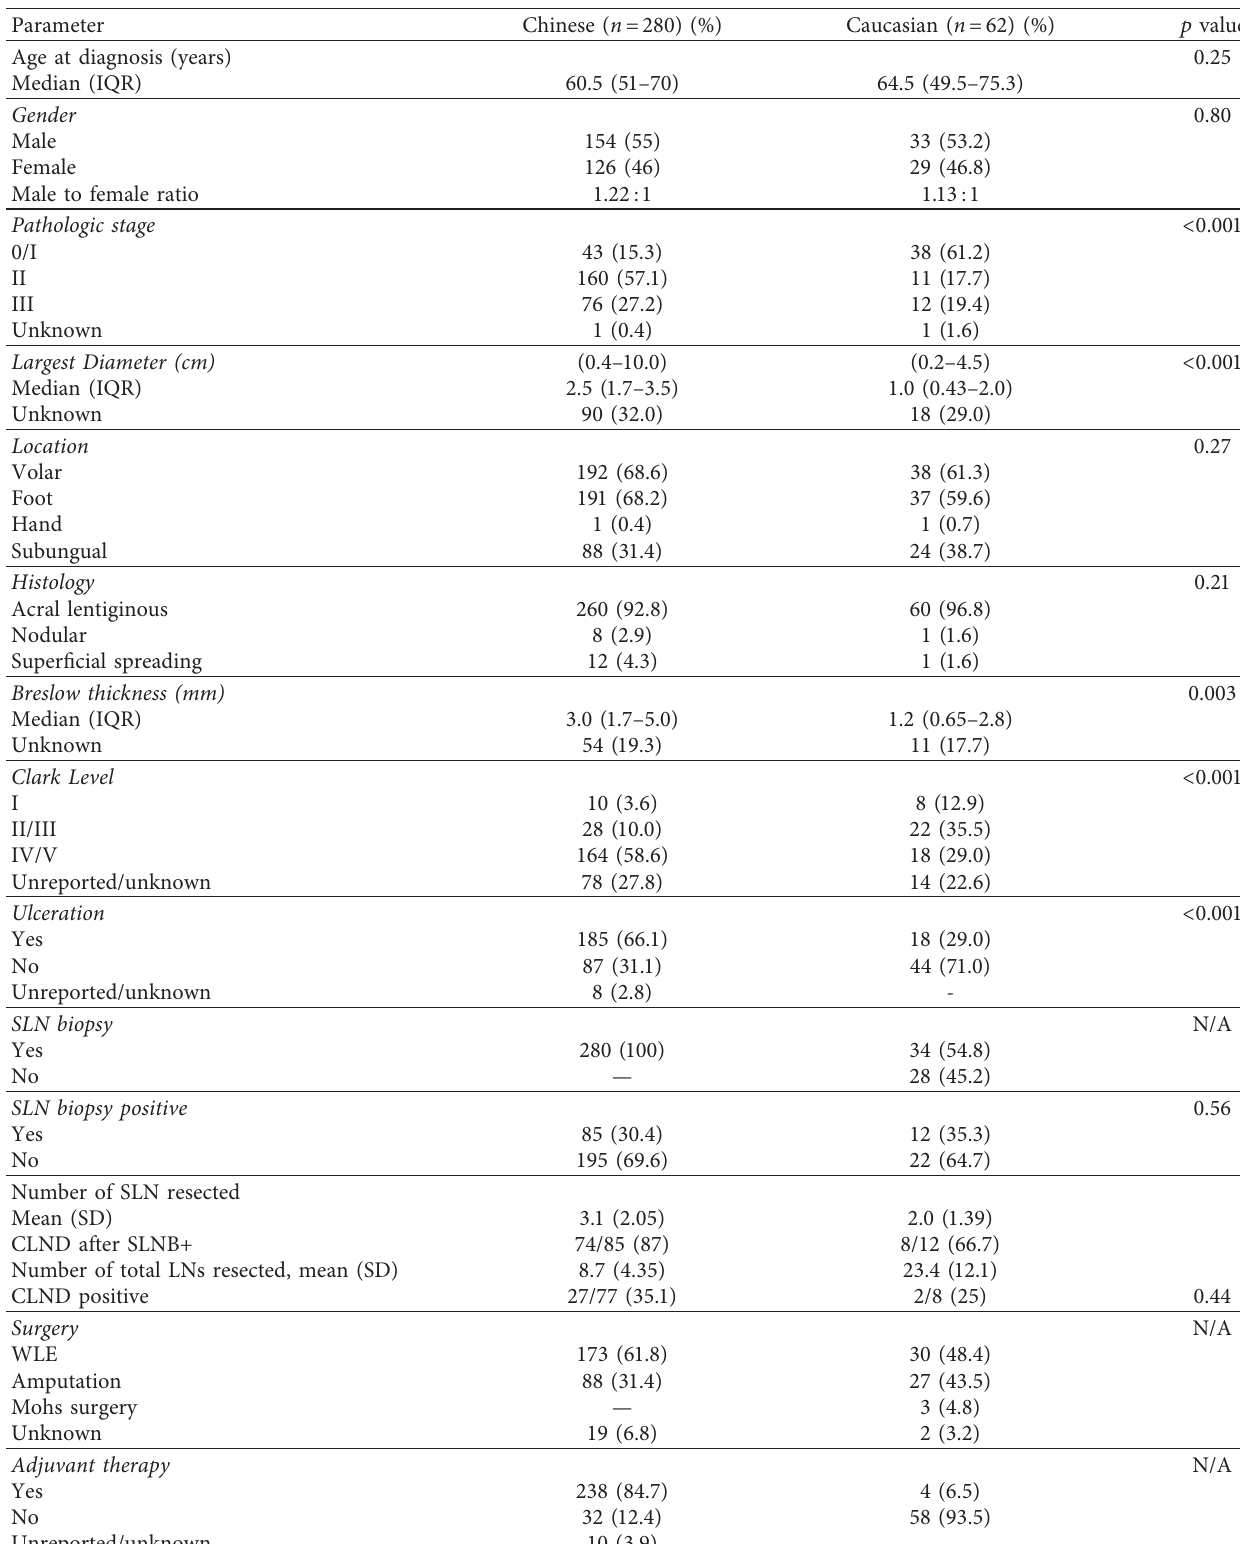
Table 1: Clinical and pathological parameters of AM patients in Chinese ( n � 280) and Caucasians ( n �